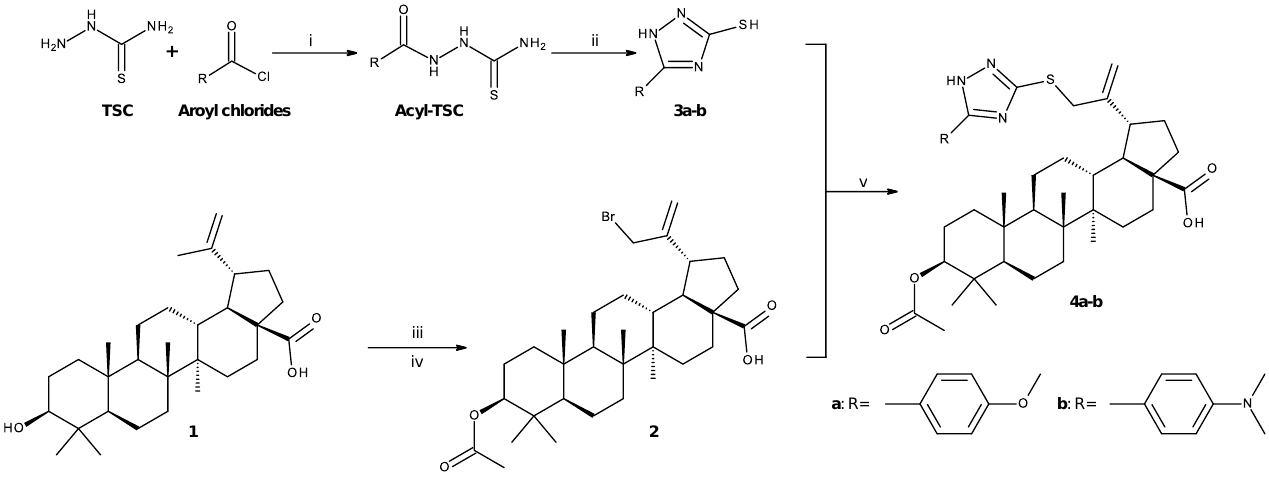
Figure 3 . Synthesis pathways used to obtain BA−triazol derivatives; TSC = thiosemicarbazide, 1 − Figure 3. Synthesis pathways used to obtain BA − triazol derivatives; TSC = thiosemicarbazide, betulinic acid, 2 − 3β−O−Acetyl−30−bromo−betulinic acid, 3a − 5−(4−methoxyphenyl)−1H−1,2,4−tri- 1 —betulinic acid, 2 —3 β − O − Acetyl − 30 − bromo − betulinic acid, 3a —5 − (4 − methoxyphenyl) − 1H − azole−3−thiol, 3b − 5−[4−(dimethylamino)phenyl]−1H−1,2,4−triazole−3−thiol, 4a − 3β−O−Ace- 1,2,4 − triazole − 3 − thiol, 3b − 5 − [4 − (dimethylamino)phenyl] − 1H − 1,2,4 − triazole − 3 − thiol, 4a — tyl−30−[5−(4−methoxyphenyl)−1H−1,2,4−triazol−3−ylsulfanyl]−betulinic acid, 4b − 3β−O−Ace-